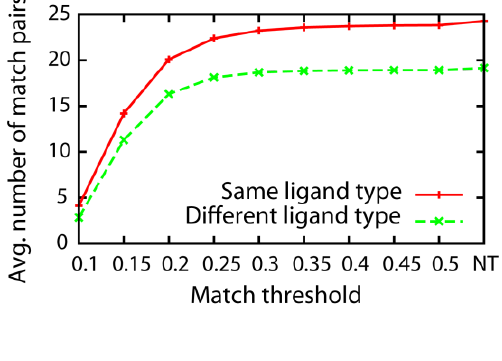
Figure 5. The number of paired patches between same ligand types (red) and different ligand types